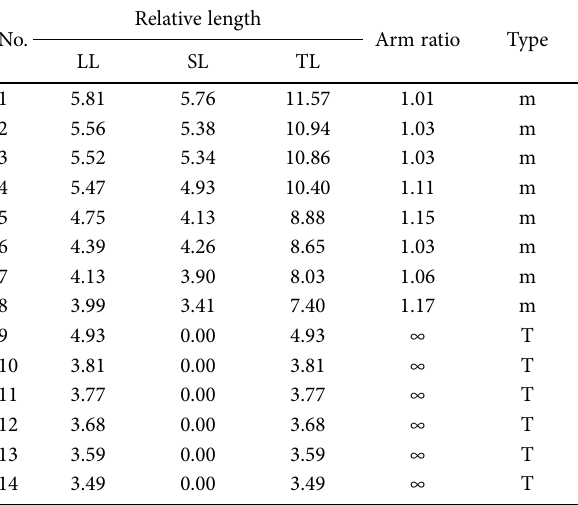
Table 3. Measurements of somatic chromosomes of L . aurea